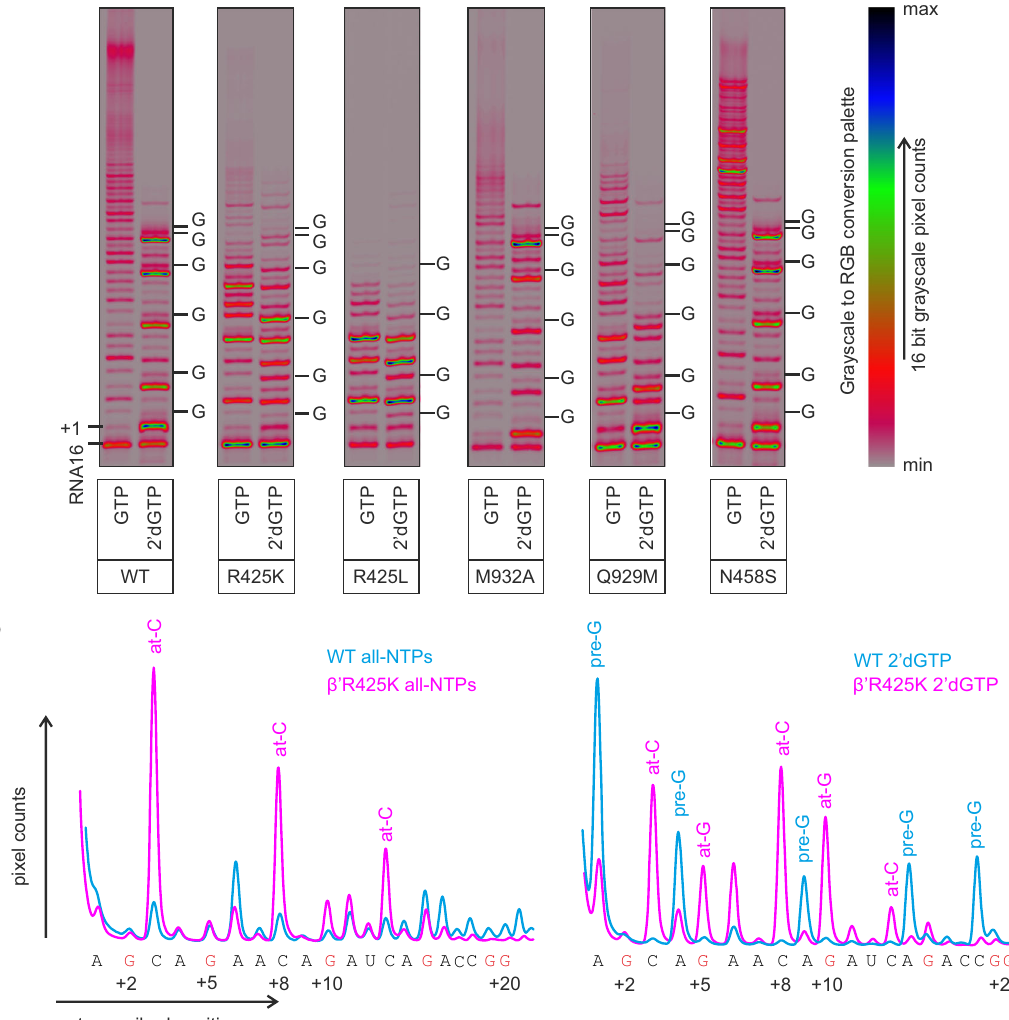
Fig. 4 Utilization of 2 ′ dGTP during processive transcription by the WT and variant E. coli RNAPs. a TECs were assembled using the scaffold shown above the gel panels and chased with 50 µ M ATP, CTP, UTP, and GTP or 2 ′ dGTP for 2 min at 25 °C. The positions of GMPs in resolved stretches of the transcribed sequence are marked along the right edge of gel panels; 16-bit grayscale scans were normalized using max pixel counts within each gel panel and pseudo-colored using RGB palette. b Lane pro fi les of transcription in all-NTPs and 2 ′ dGTP chases by the WT (cyan) and β ′ R425K (magenta) RNAPs quanti fi ed from gels in a . Traces were manually aligned along the X -axis and scaled along the Y -axis using several sequence positions as references. All experiments were repeated in triplicate with similar results. Source data are provided as a Source Data fi